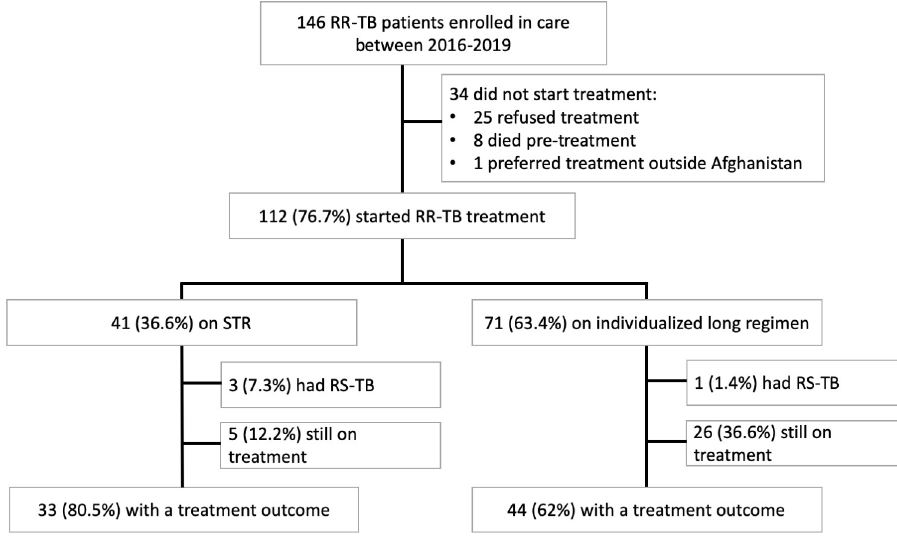
Fig 1. Kandahar cohort